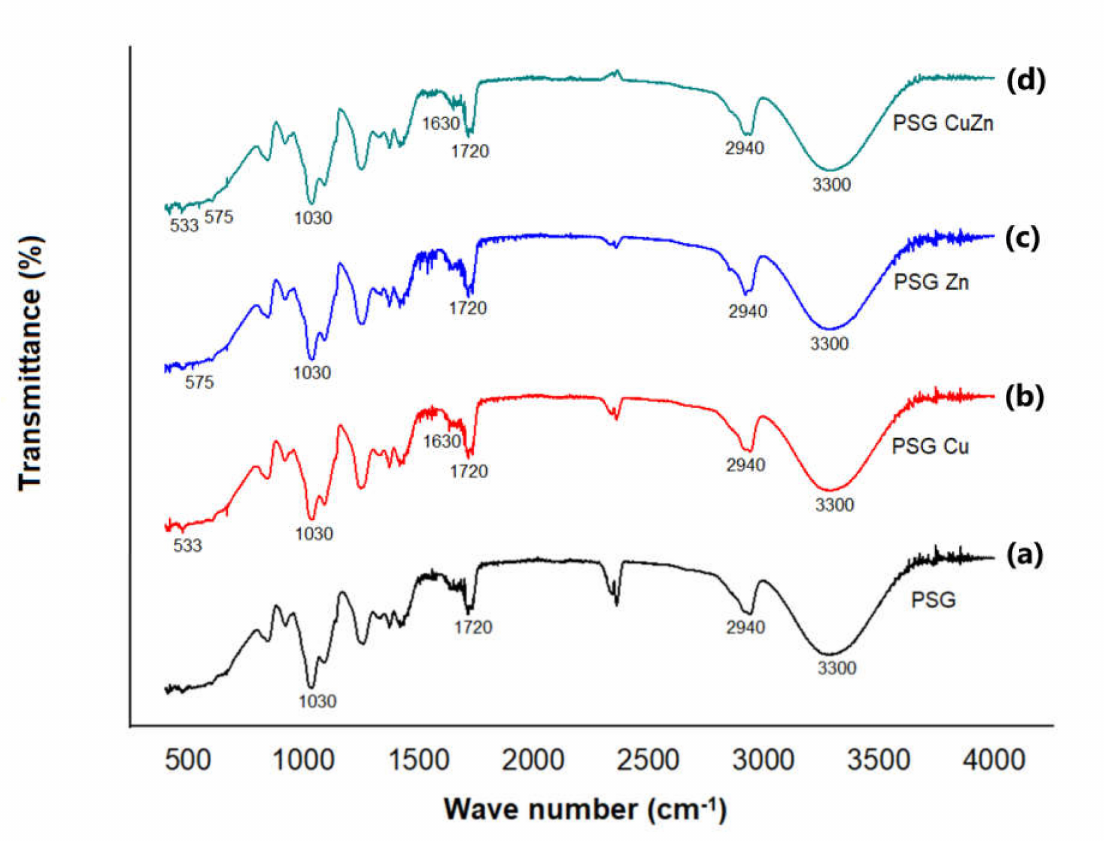
Figure 3. FTIR-ATR spectra of ( a ) PSG, ( b ) PSG-Cu, ( c ) PSG-Zn, and ( d )PSG-CuZn films analyzing the organic and inorganic components of the developed polymer composite